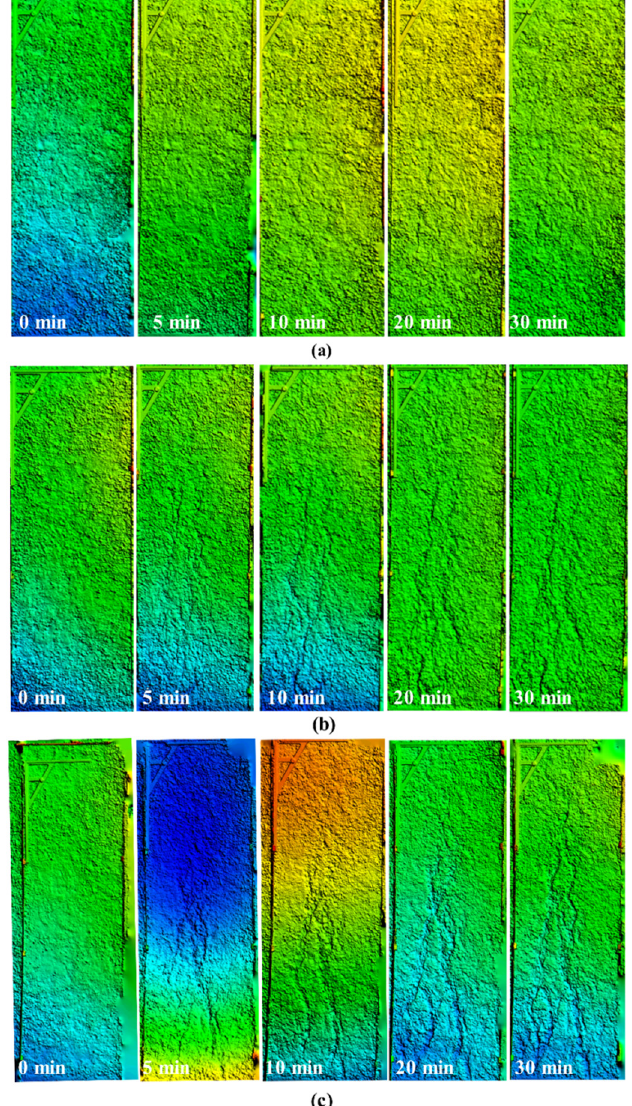
Figure 4. DEM map at fixed time under different rainfall intensities. ( a ) rainfall intensity was 2.0 mm/min; ( b ) rainfall intensity was 2.5 mm/min and ( c ) rainfall intensity was 3.0 mm/min.